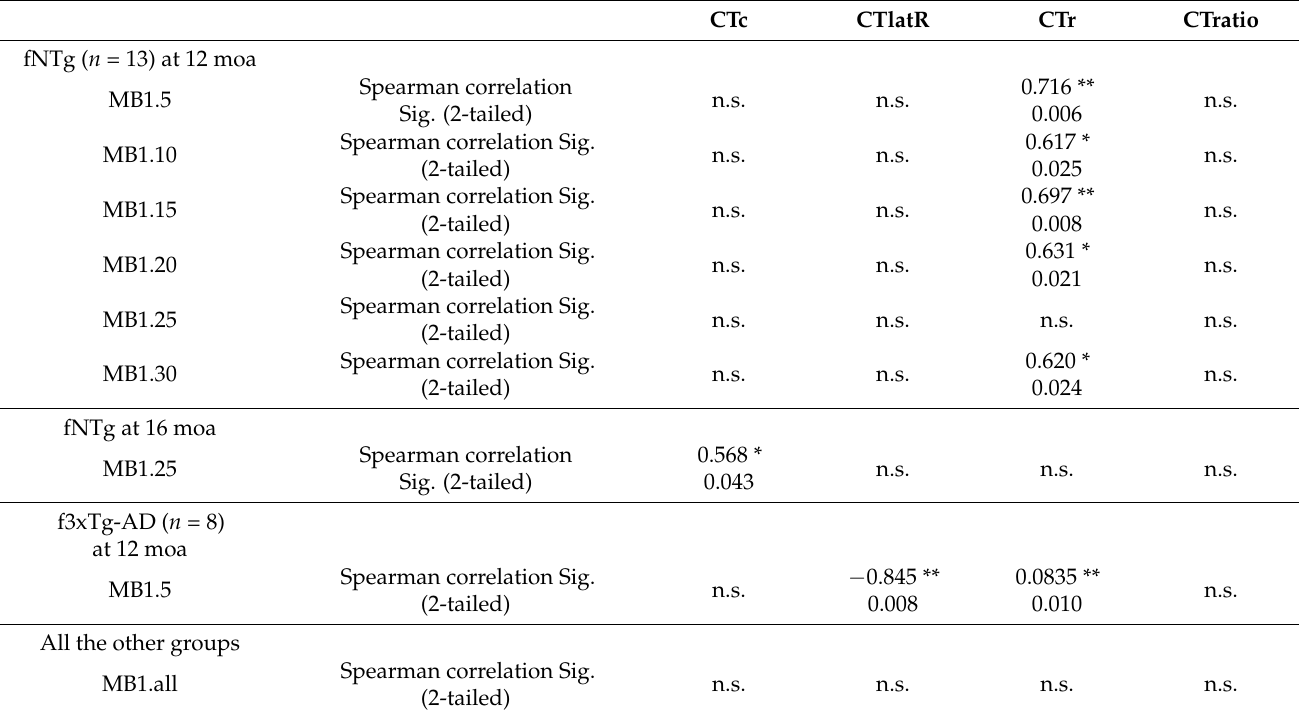
Table 3. Corner test and marble burying test Spearman correlation